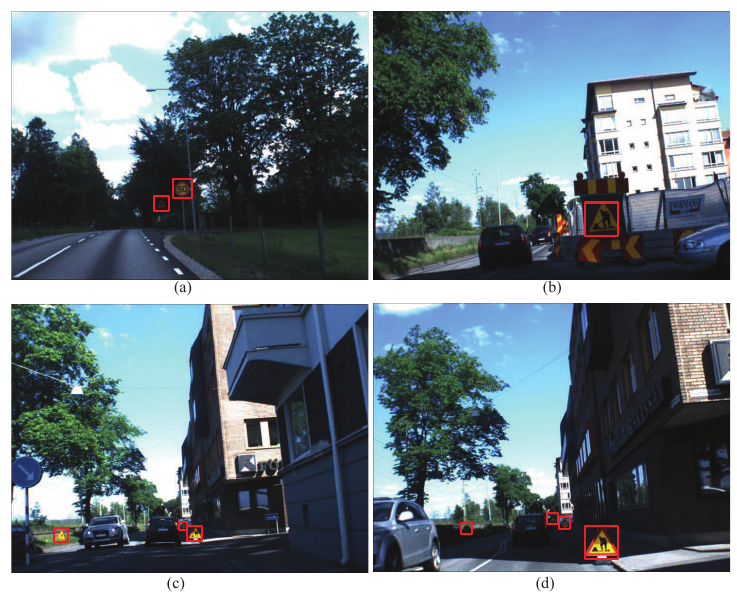
Figure 11. Part of our detection results. The images from ( a – d ) are the detected results from CVL